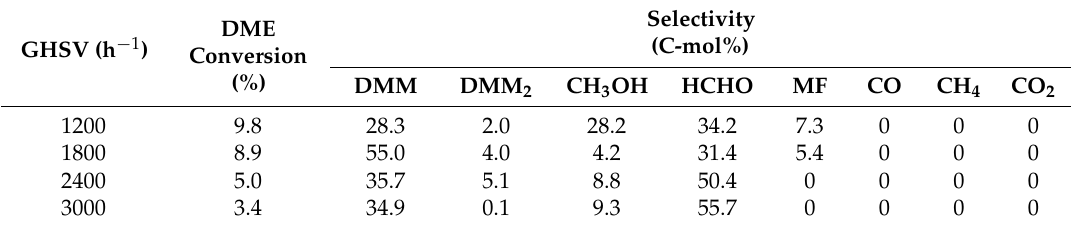
Table 3. Effects of GHSV on the performance of 5%Re-30%PW 12 /CNTs.